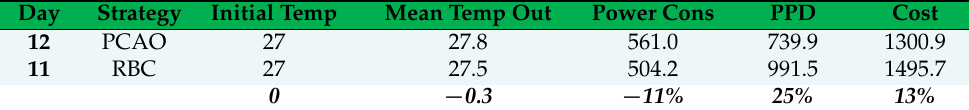
Table 8. Comparison between the PCAO (12th) and RBC (11th) summer days.